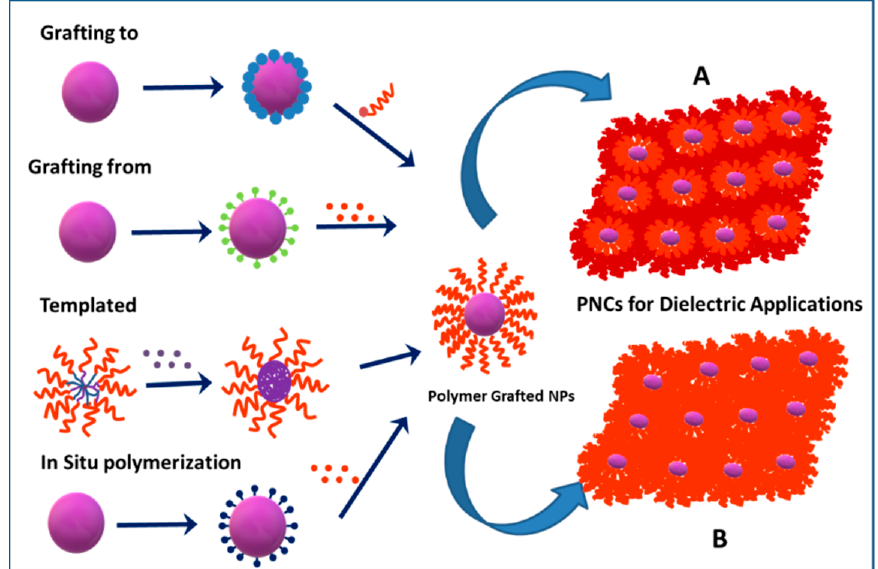
Figure 2. Approaches for grafting polymer chains on the surface of nanomaterials. ( A ) Polymer-nanocomposite formed from polymer-grafted NPs and polymer matrix. ( B ) Polymer nanocomposite formed from only polymer-grafted NPs).